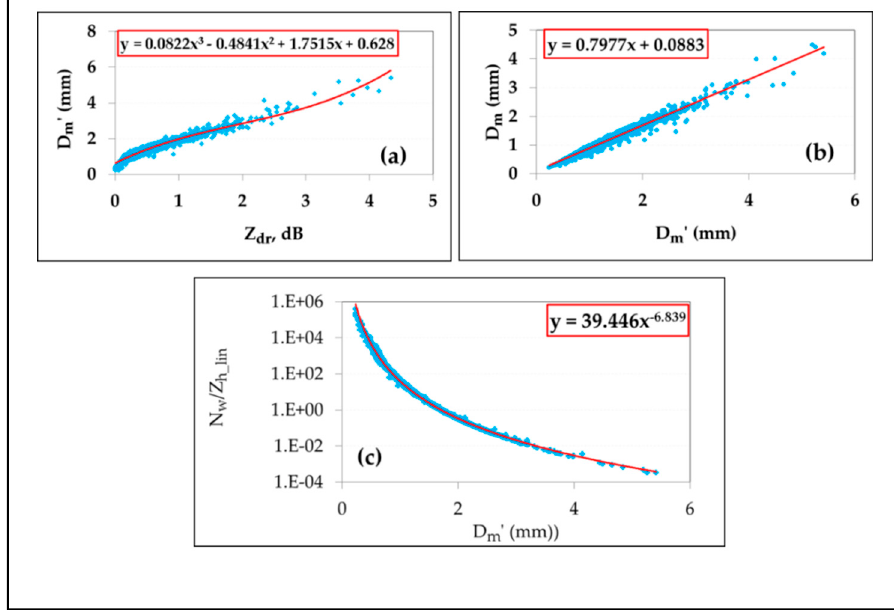
Figure 11. S-band simulation results of ( a ) D m ’ versus Z dr , ( b ) D m with D m ’, and ( c ) N W /Z h (linear) versus D m